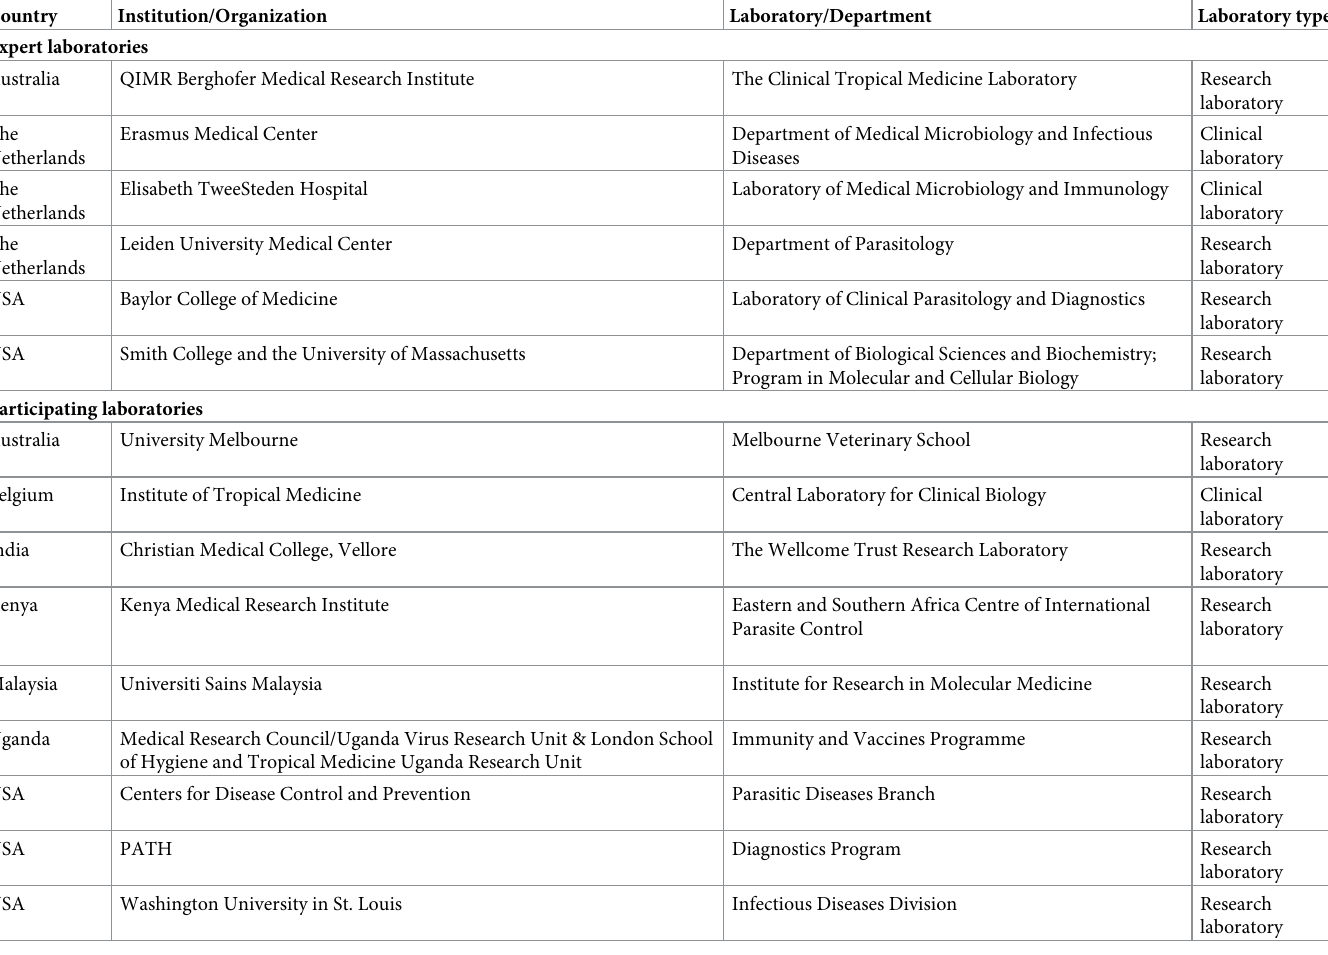
Table 1. The expert and participating laboratories of the HEMQAS pilot study. The order of the list does not correspond with the order of the laboratories in Table 5 .